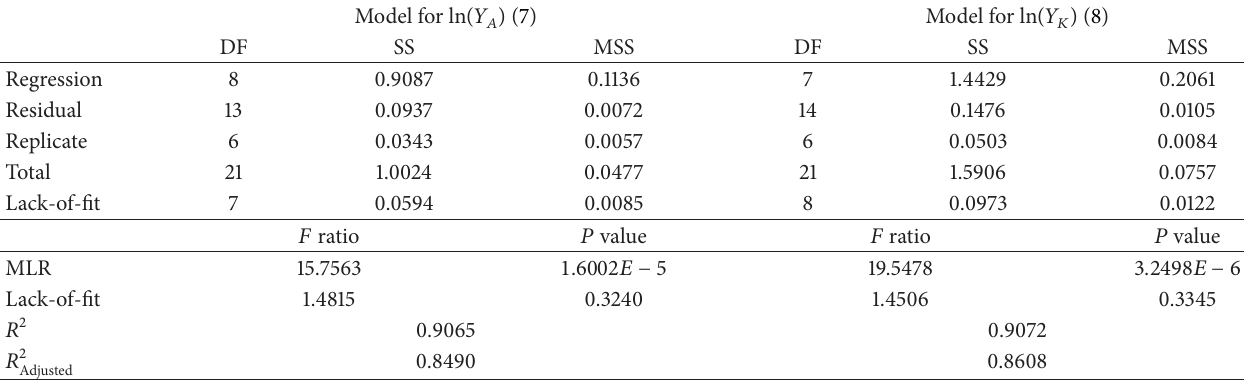
Table 4: Analyses of variance and goodness of fit for the multivariate process models for sludge yields. Model for ln (𝑌 𝐴 )